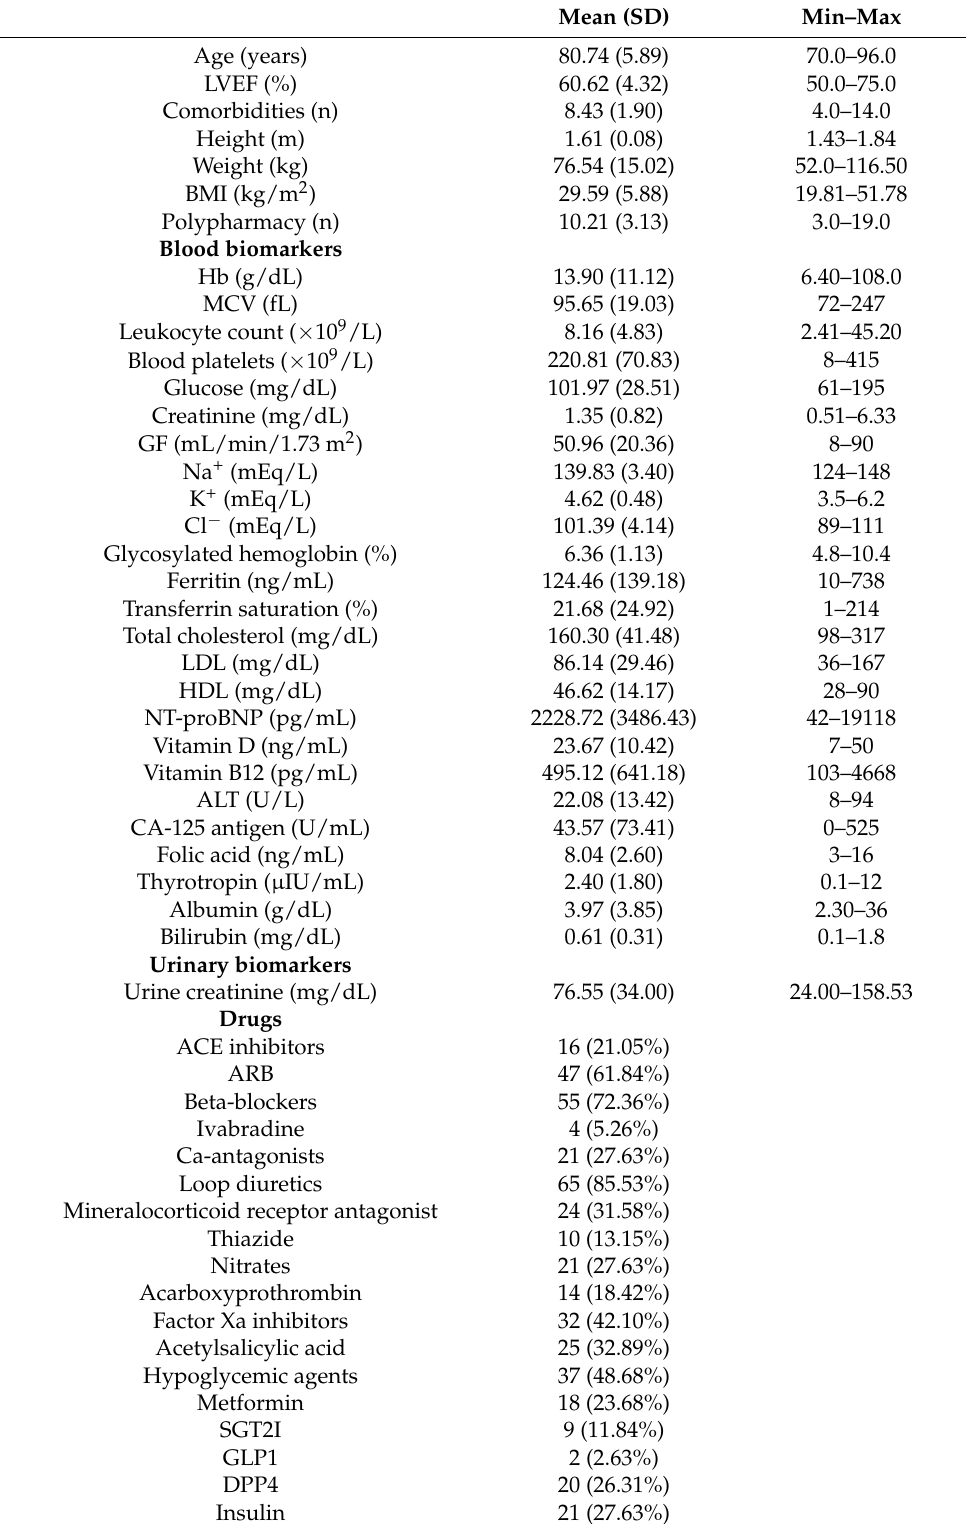
Table A1. Participants’ anthropometric, clinical-epidemiological variables, and blood and urinary biomarkers ( n =